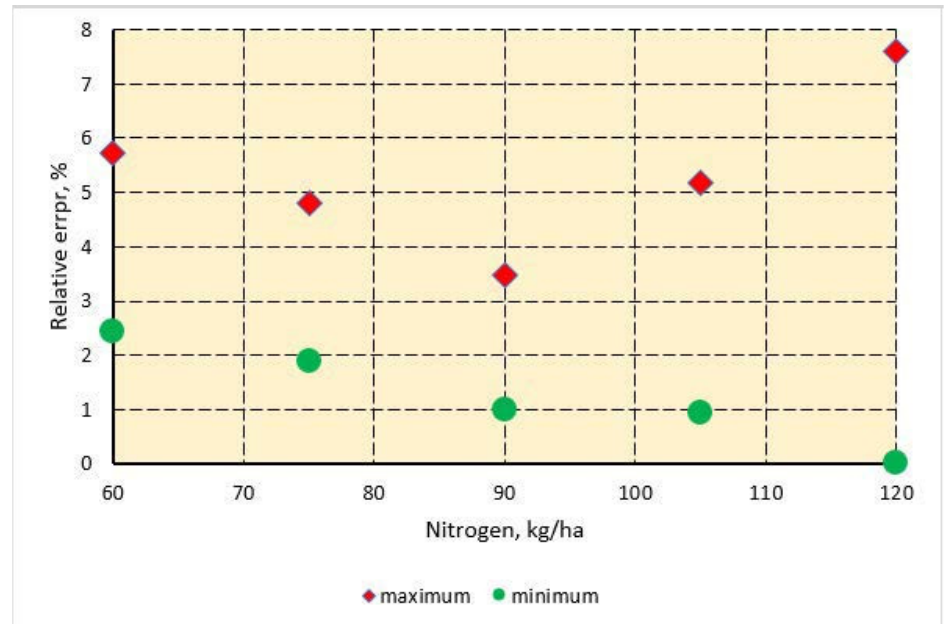
Figure 4. The relative error (the preceding crop is rapeseed).